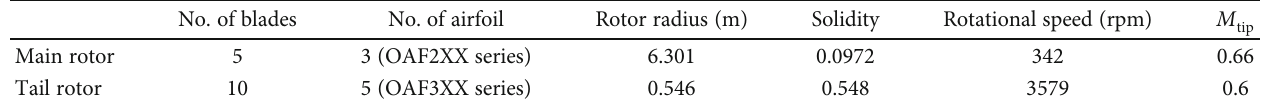
Table 1: Speci fi cation of rotors.